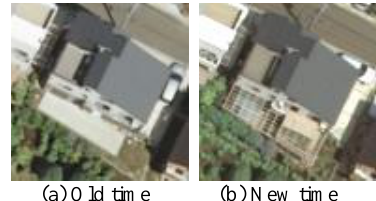
Fig.8. Changed buildings not extracted by color extraction